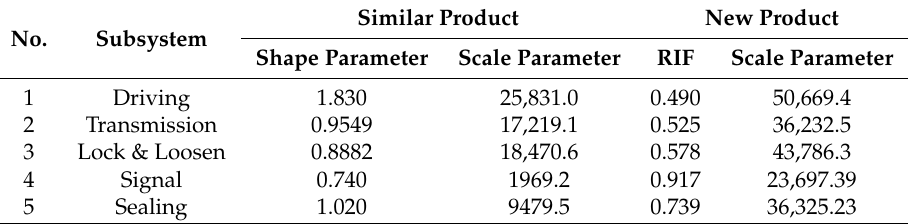
Table 3. The reliability model of each subsystem before and after the upgrade. RIF: reliability improvement